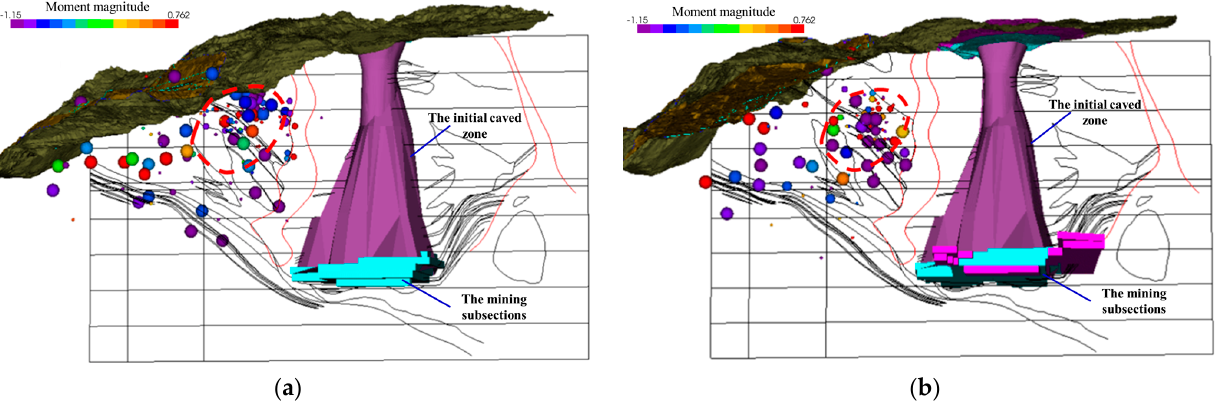
Figure 11. Microseismic data near the A38 profile. ( a ) Monitoring data in 2012; ( b ) monitoring data in 2013.